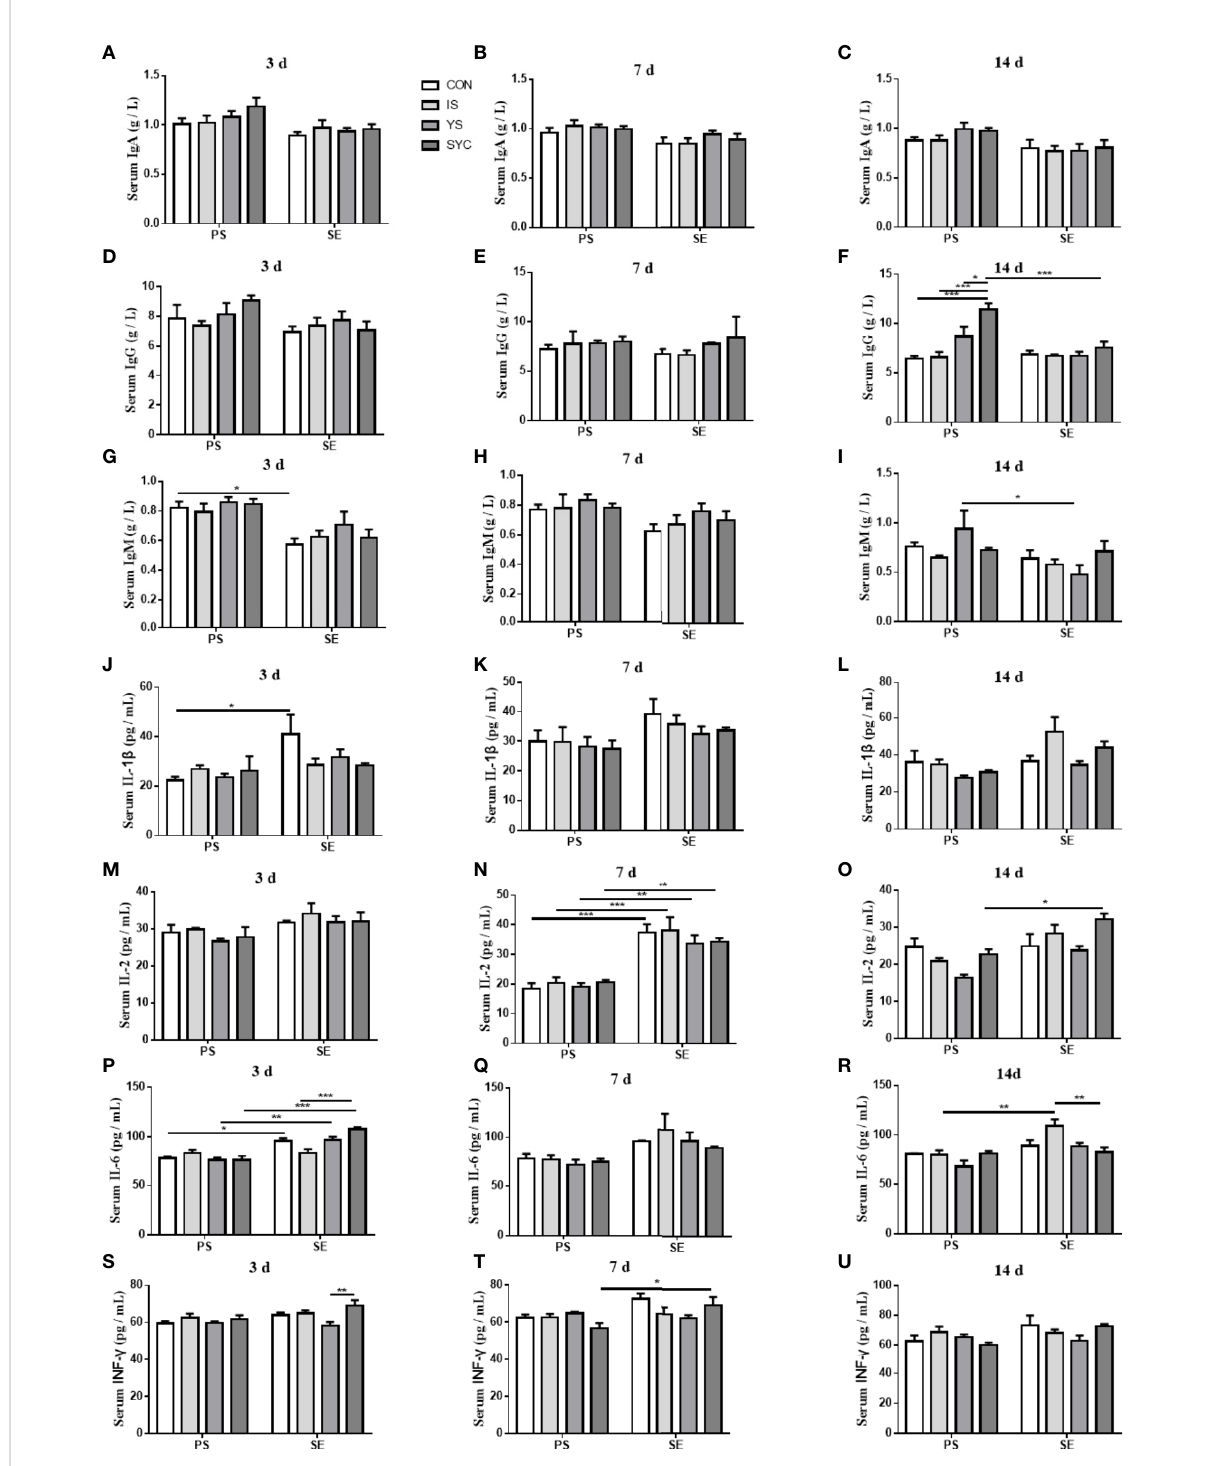
FIGURE 4 Effects of dietary supplementation with different Se sources on the serum parameters of layers challenged with S. Enteritidis . CON, basal diet; IS, sodium selenite; YS, yeast selenium; SYC, selenium-enriched yeast culture; PS, challenged with physiological saline solution; SE, challenged with S. Enteritidis . The levels of serum IgA, IgG, IgM, IL-2, Il-6, IL- b , and INF- g were measured among different periods and treatments (A – U) . The data were presented as mean ± SEM. Signi fi cance was compared with every other group; * P < 0.05, ** P < 0.01, *** P <